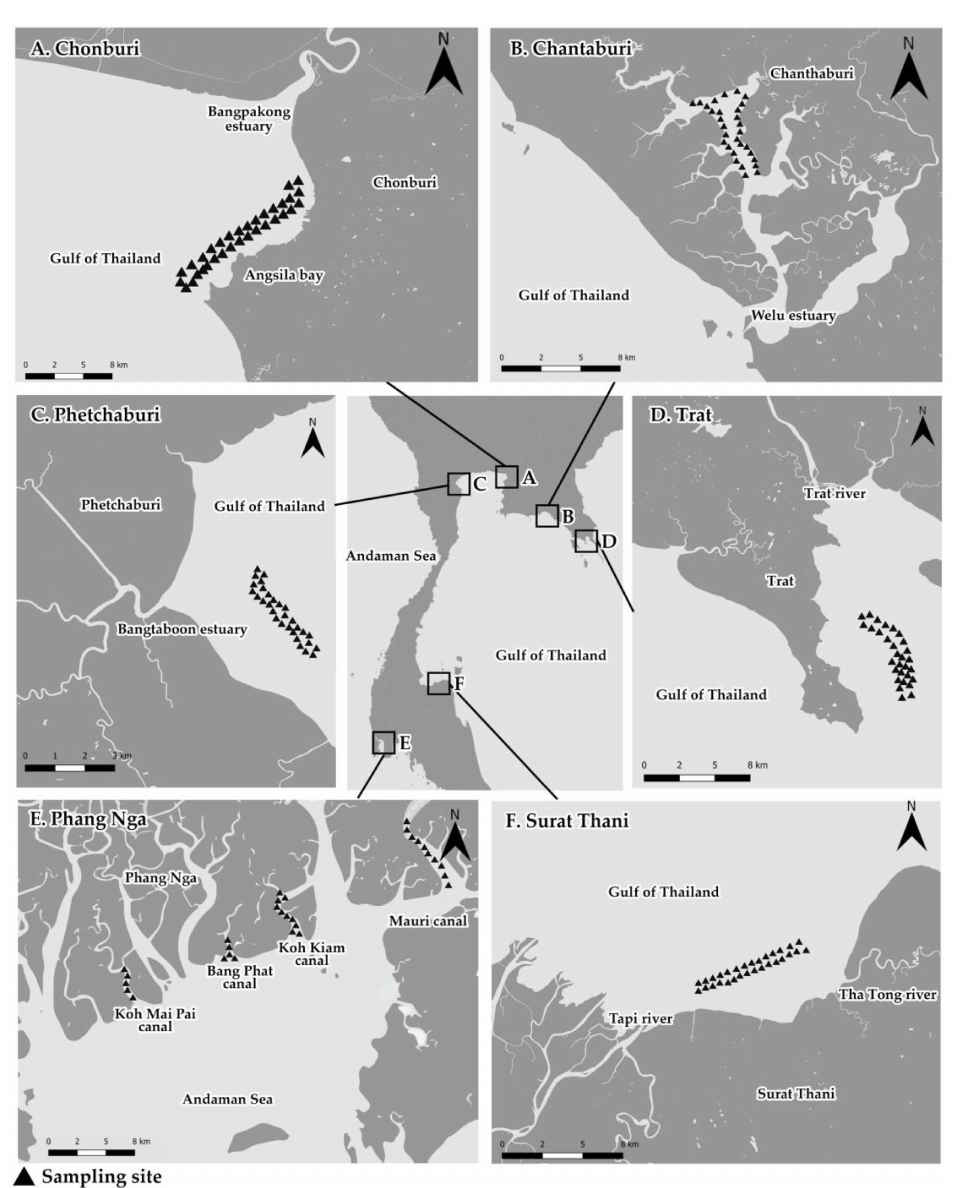
Figure 1. Geographical distribution of water sampling locations from the high-density areas of oyster cultivation in ( A ) Chonburi, ( B ) Chanthaburi, ( C ) Phetchaburi, ( D ) Trat, ( E ) Phang Nga, and ( F ) Surat Thani provinces (n =